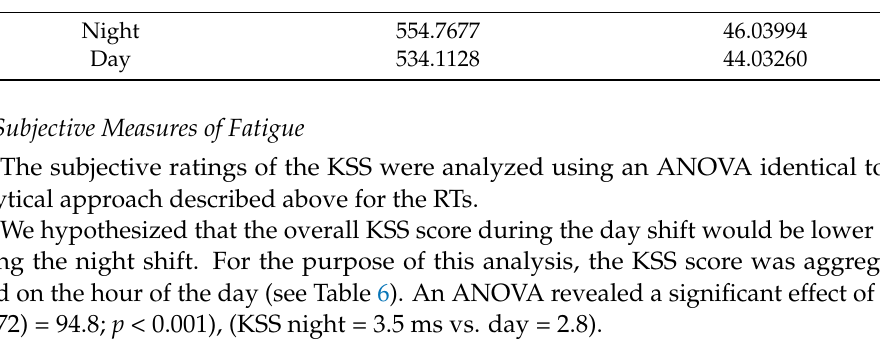
Table 6. Descriptive results of the KSS scores (dependent variable: Mean fatigue